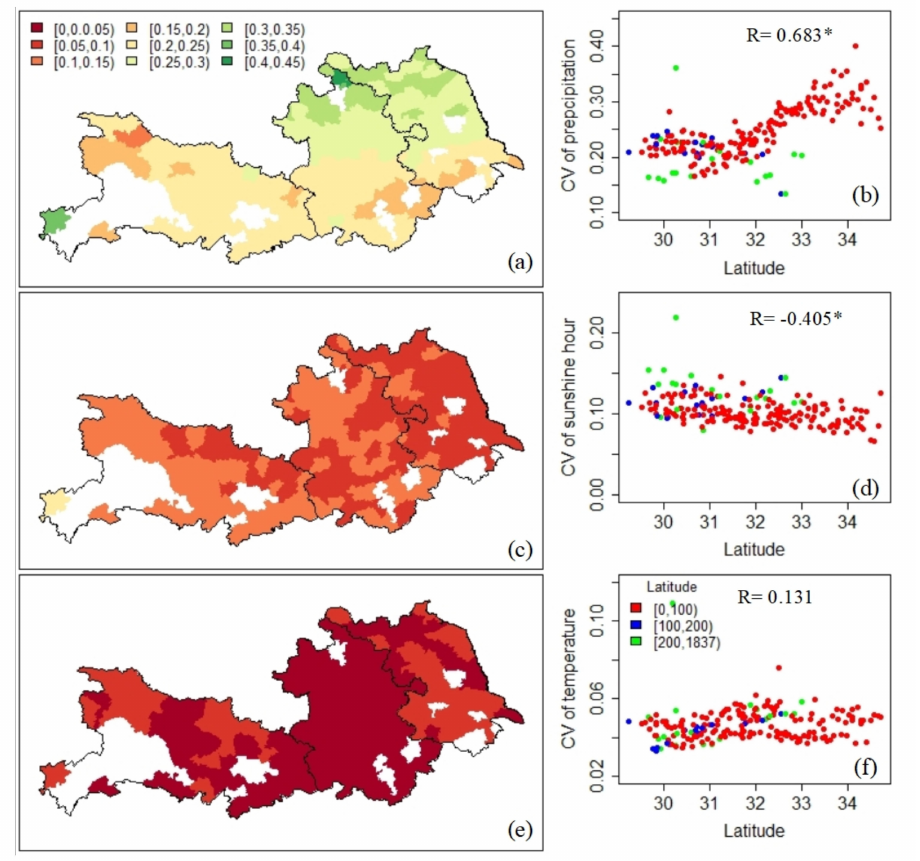
Figure 3. Spatial pattern of CV of total precipitation ( a ), average sunshine hours ( c ) and average maxi- mum temperature ( e ) across growing season, and the corresponding scatter plots of latitude and CV of total precipitation ( b ), CV of average sunshine hours ( d ) and CV of average maximum temperature ( f ). The asterisk (*) indicates that the correlation between them has passed the significance